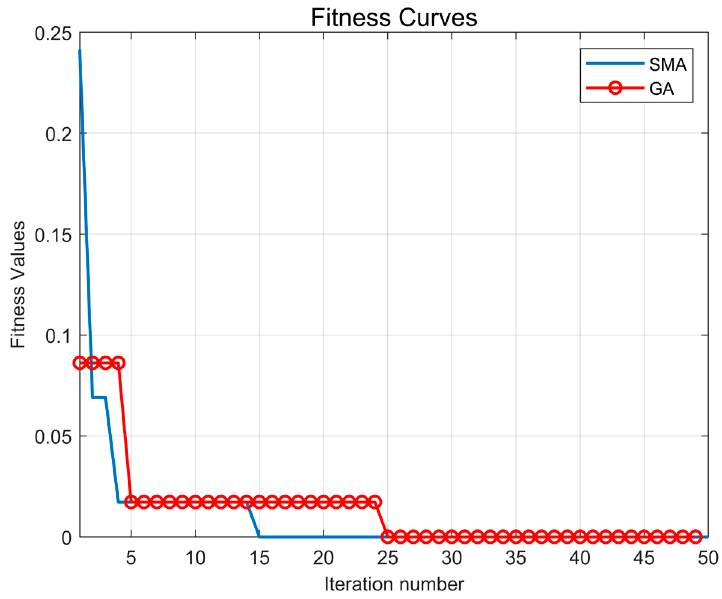
Figure 6. Fitness Curve.